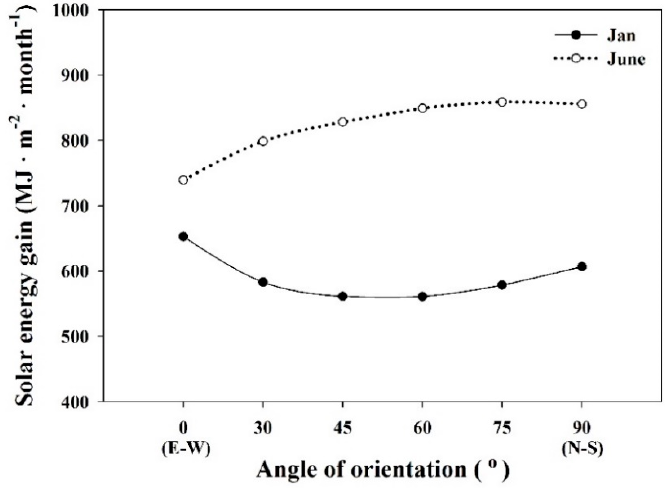
Figure 11. Solar energy gain at different angles of orientations, of a gothic ‐ shaped roof.